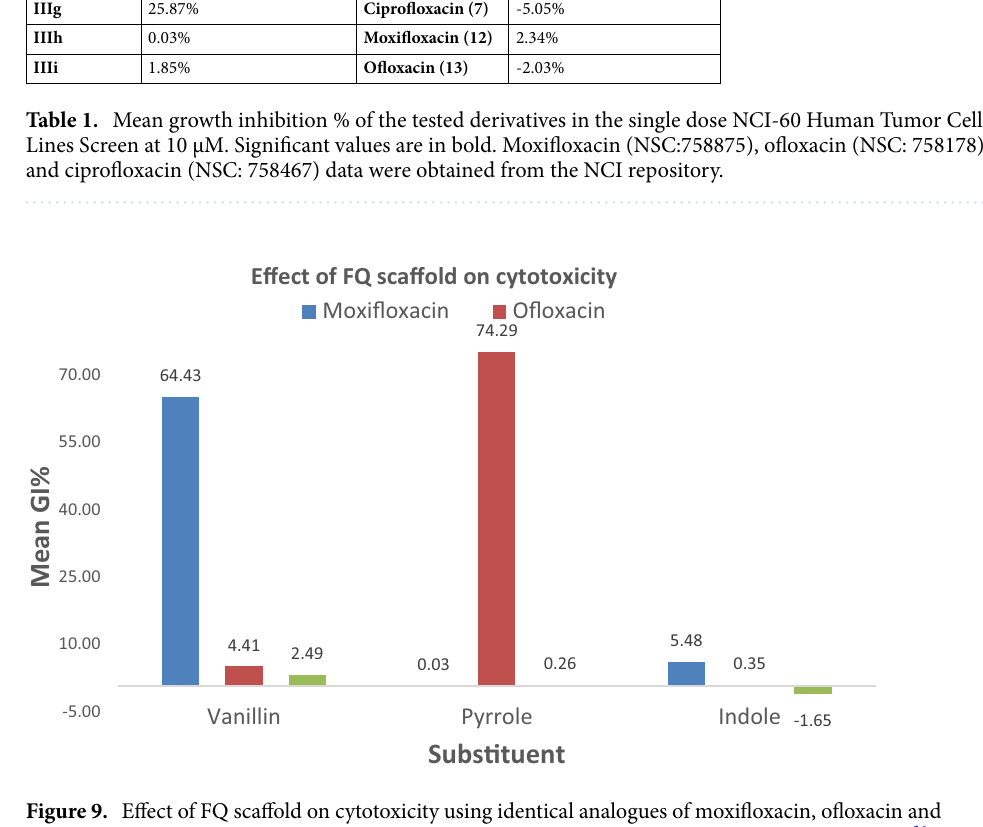
Figure 9. Effect of FQ scaffold on cytotoxicity using identical analogues of moxifloxacin, ofloxacin and ciprofloxacin. Generated using Tableau 2022.3. (2022). (https:// www. table au. com/ produ cts/ deskt op) 36